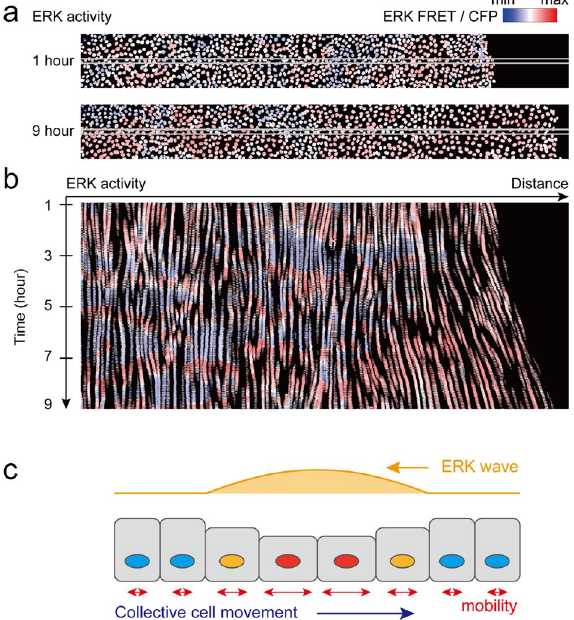
Figure 1. Live imaging of ERK-induced collective cell migration ( a ). Visualization of ERK activity during wound-healing in epithelial MDCK cell sheet expressing the FRET-based biosensor of ERK. Snapshots are presented at 1 h (upper panel) and 9 h (lower panel) after scratching. Red and blue colors indicate high and low ERK activity, respectively. Note that the cytosol is not visualized, since the FRET-based biosensor is localized only in the nucleus 6,10 . ( b ) A kymograph of ERK activity images in a band region of interest indicated by the